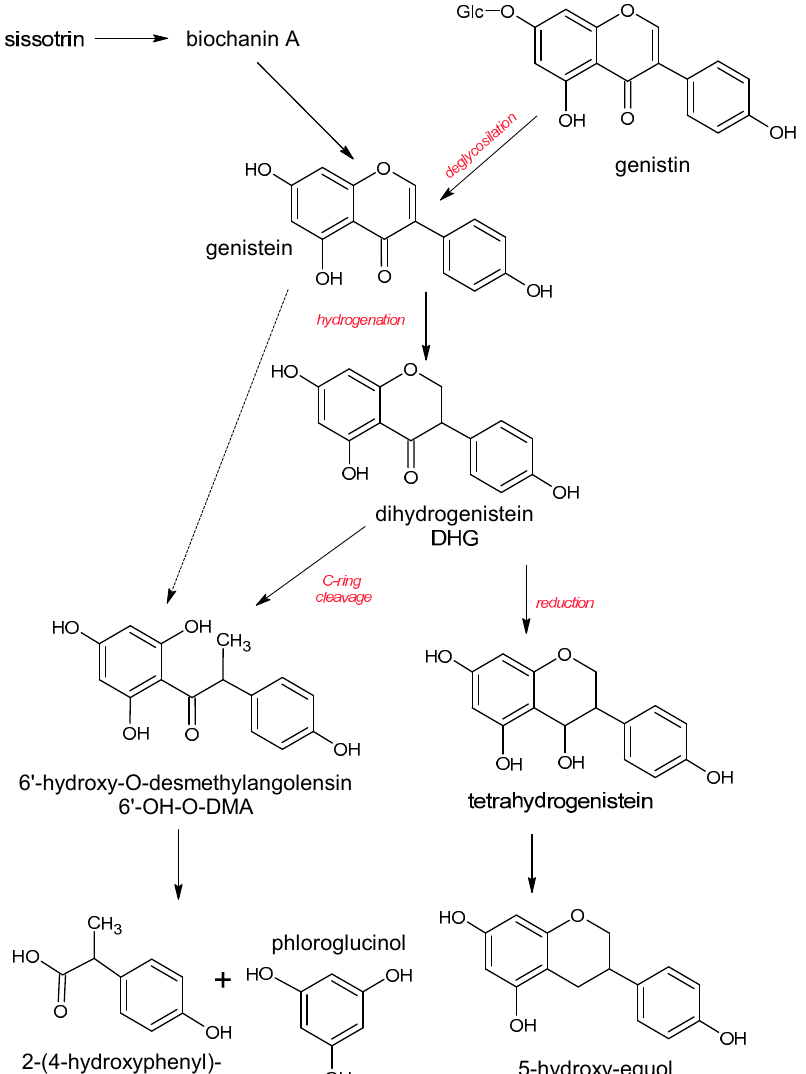
Figure 5. Possible pathways of microbial metabolism of genistin and genistein. Based on [236–243]. The dashed arrows indicate hypothesized pathways of microbiological degradation that were observed in vitro but were not reported in vivo.